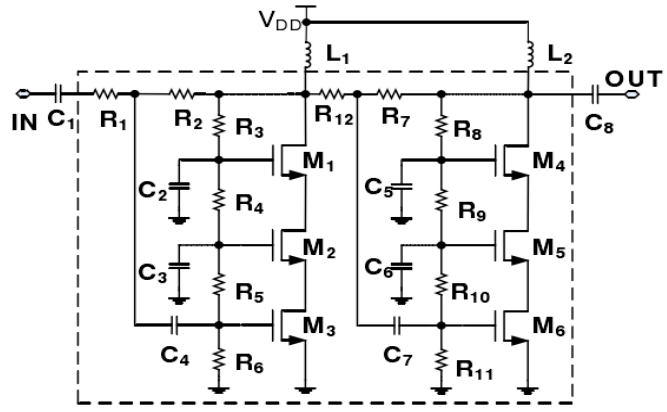
Figure 1. The schematic of the 2.5–5.2 GHz CMOS Class-A PA.